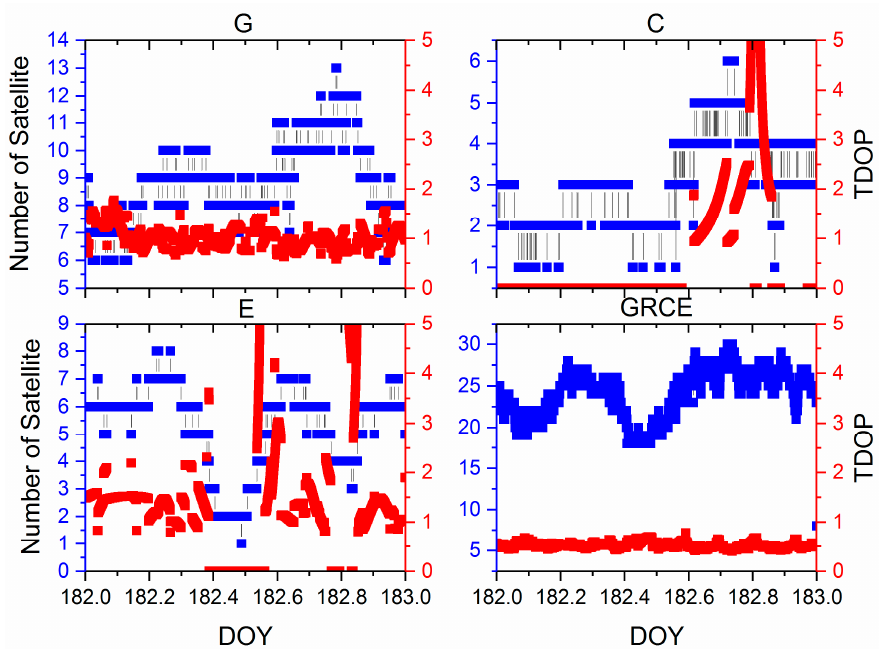
Figure 6. Number of satellites and time dilution of precision (TDOP) on BRUX.